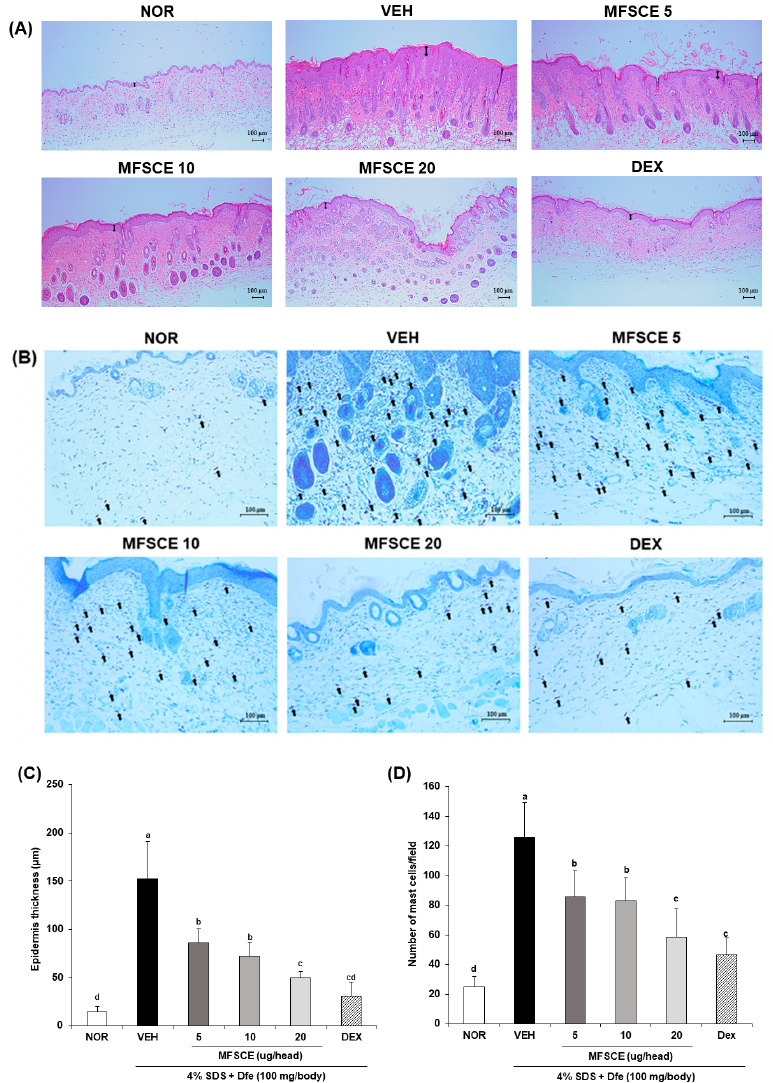
Figure 6. Effect of MFSCE on epidermal thickness and mast cell infiltration in AD-like dorsal skin of HDM-sensitized NC/Nga mice. Histological images of dorsal skin lesions for hematoxylin and eosin staining (40× magni fi cation) ( A ) and toluidine blue staining (100× magni fi cation) ( B ). Quanti- fi cation of epidermal thickness ( C ) and mast cells ( D ) per fi eld. Values are mean ± SD. a–d Means with di ff erent le tt ers are signi fi cantly di ff erent ( p < 0.05) as determined by Duncan’s multiple range test. The mice were grouped and treated as described in Figure 2.